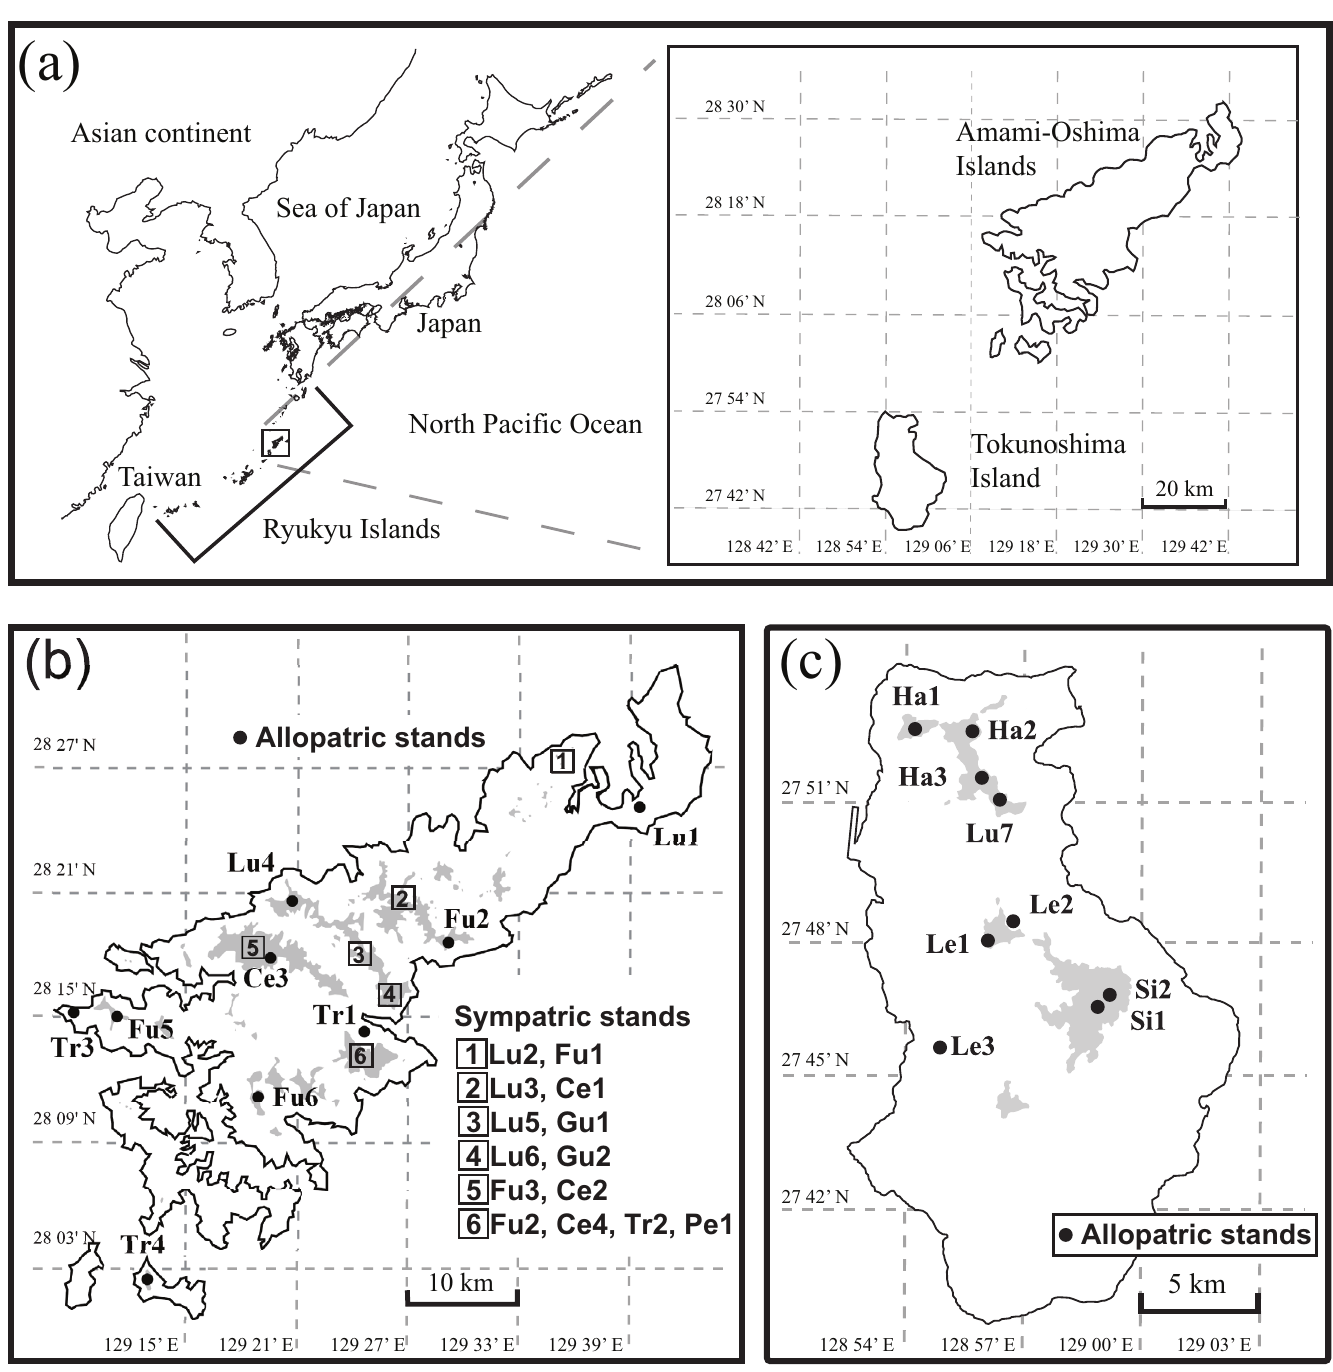
Fig 1. Map showing the location of the sampling sites. (a) area map with the Ryukyu Archipelagopositioned centrally; (b) Amami-Oshima Island; (c) Tokunoshima Island. Dark gray regions indicate altitudes exceeding350 m; closed circles denoteallopatricstands; squaresrepresent sympatric stands.